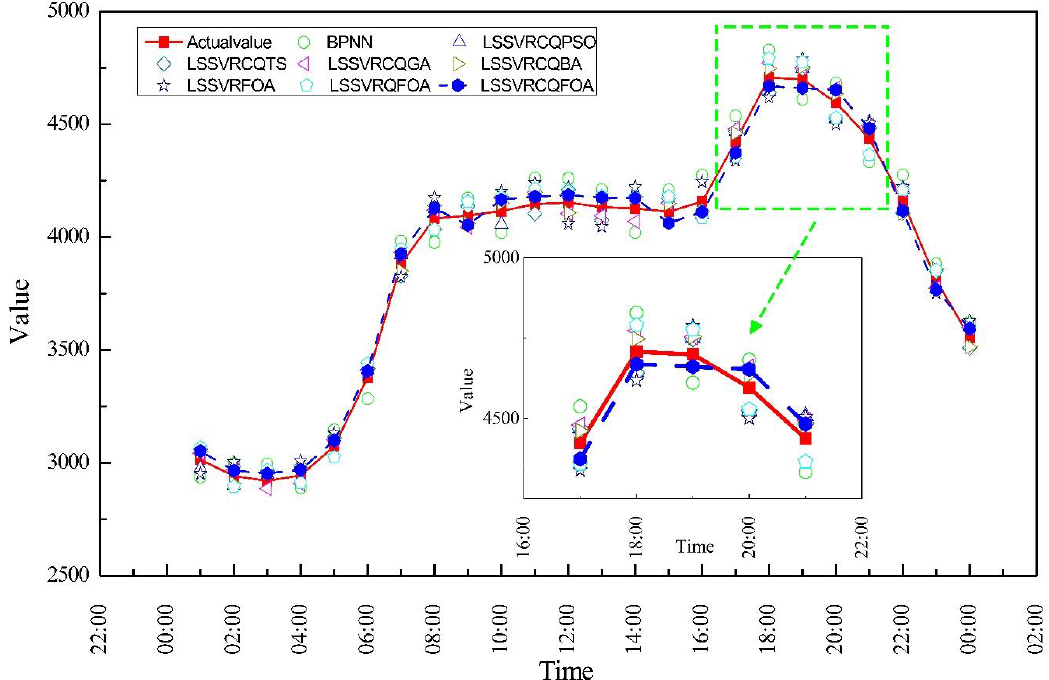
Figure 3. Forecasting values of LS-SVR-CQFOA and other models for GEFCom2014 (Jan.).